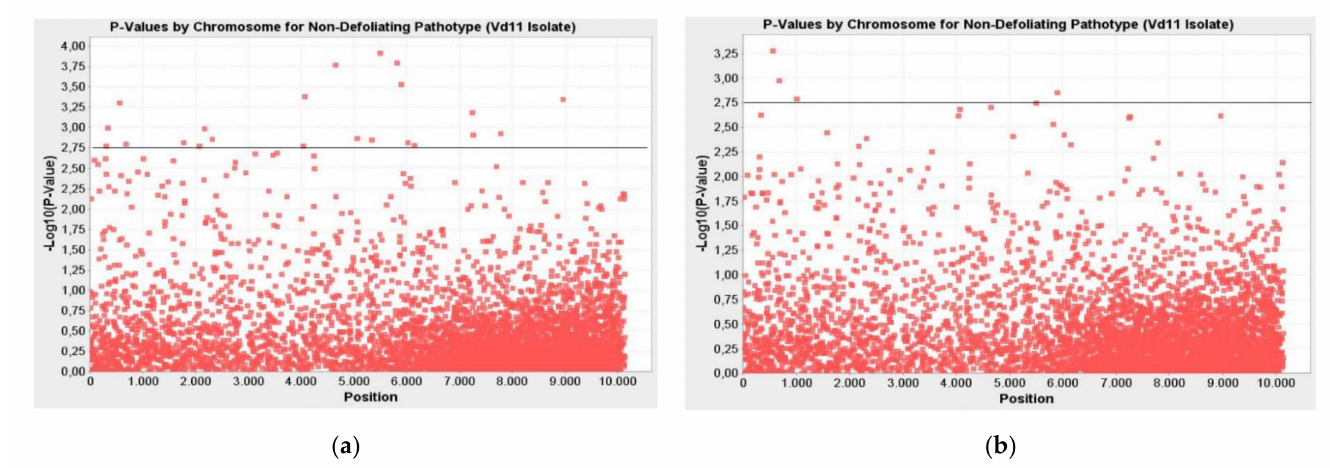
Figure 3. Manhattan plots for markers associated with non-defoliating pathotype (Vd11 isolate) of Verticillium wilt disease; ( a ) GLM; ( b ) MLM; the line indicates the significance threshold (-LOG10 ( p -Value) <